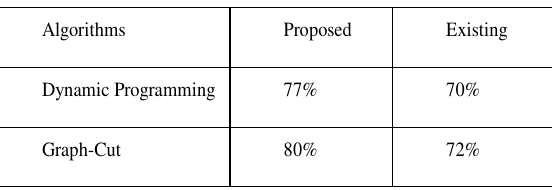
Table 1.Comparison of accuracy using SSIM between proposed and existing